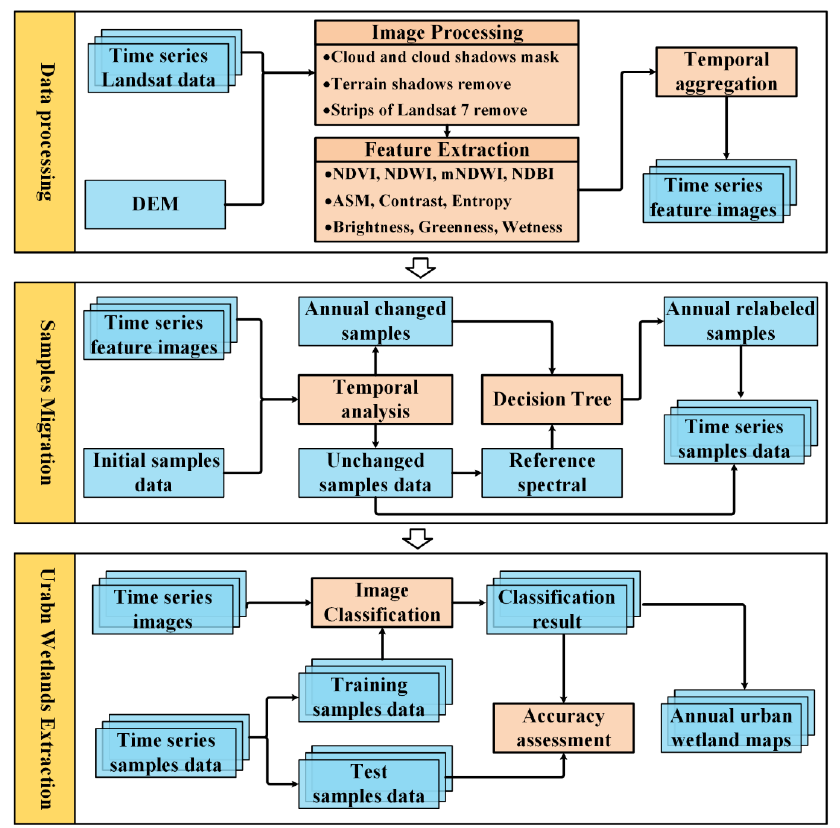
Figure 2. General workflow of the MUW_SM&RF.